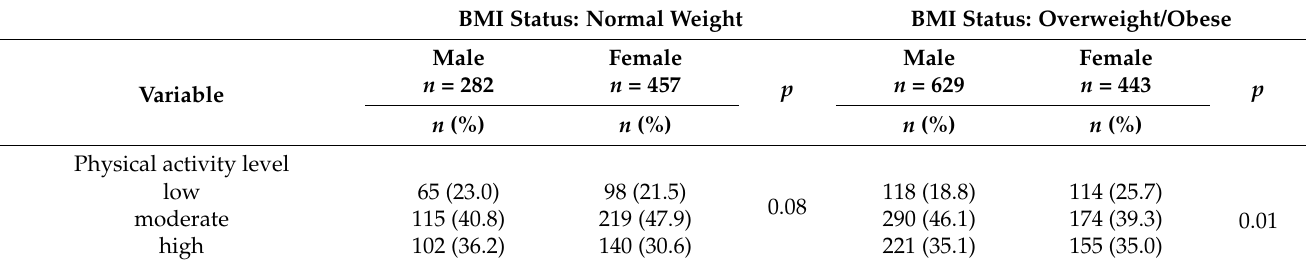
Table 3. Physical activity level by BMI status and gender ( n =